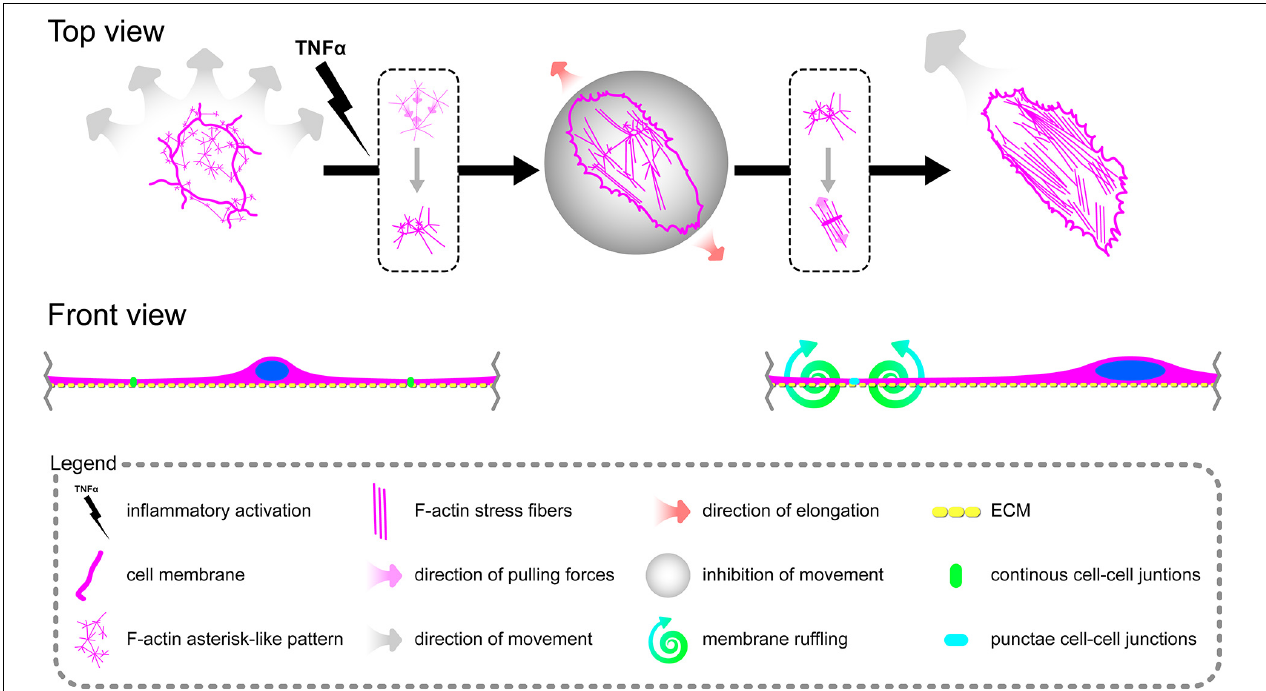
FIGURE 9 | Schematic overview of TNF α -induced reorganization of F-actin and its effect on migration of pHCAECs.